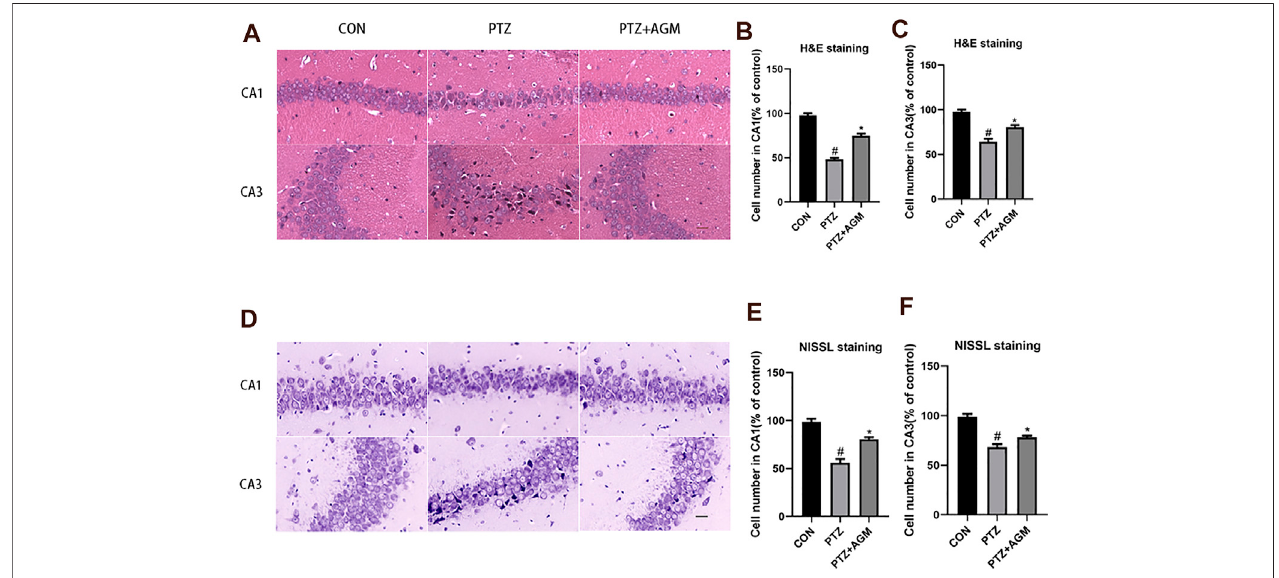
FIGURE 2 | Effects of AGM on hippocampal neurol damage induced by PTZ kindling. (A,D) Representative micrographs (original magni fi cation, × 200) showing AGMblockedhippocampalneuronaldamageinducedbyPTZkindlinginCA1andCA3areasbyHEstainingandNISSLstaining.Scalebar (cid:1) 100px. (B,C,E,F) Statistical results showing AGM increase surviving cell number in CA1 and CA3 (% of control), (n (cid:1) 4 mice per group, Student ’ s test). All data are shown as mean ± standard deviation.# p ＜ 0.05 vs the control and PTZ group, * p ＜ 0.05 vs the PTZ group and PTZ + AGM group.